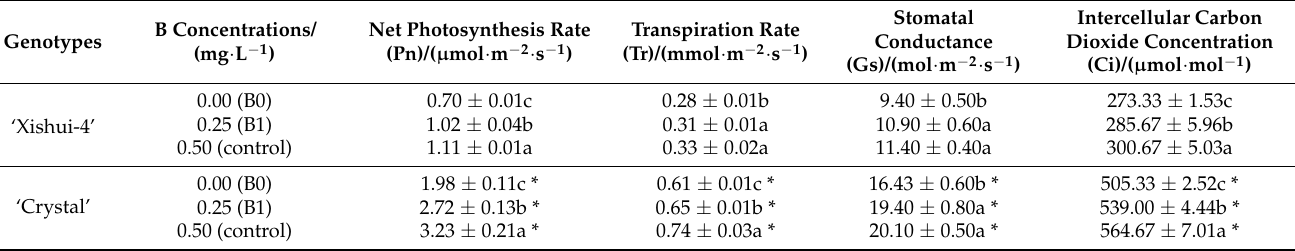
Table 4. Effects of B-deficiency on the photosynthesis of two grape genotypes.